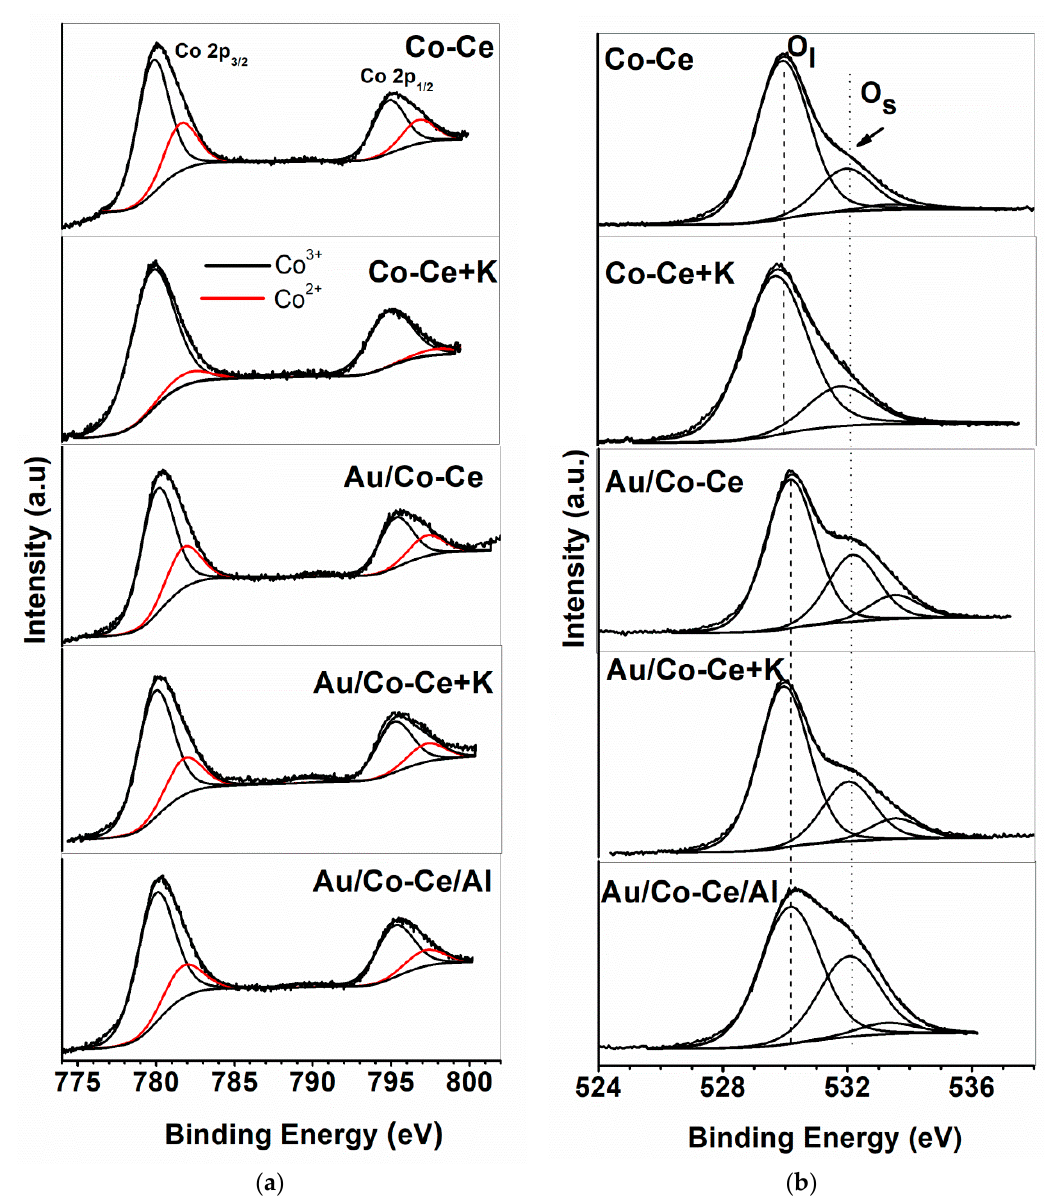
Figure 7. Co 2p XP spectra ( a ), and O 1s XP spectra ( b ) of the studied samples.